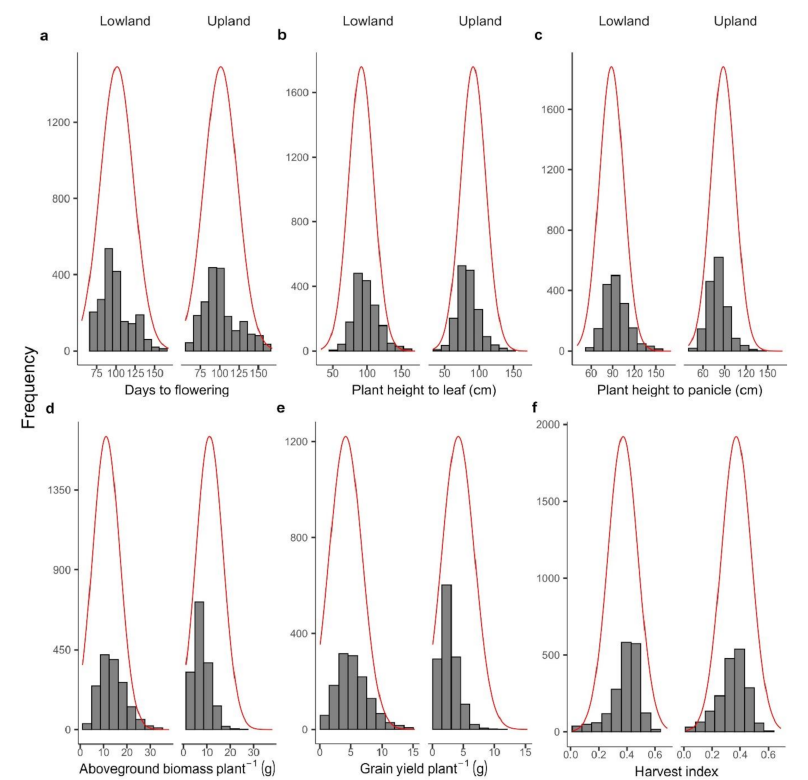
Figure 2. Frequency distribution of the six traits in lowland and upland conditions. Note: ( a ) Days to flowering. ( b ) Plant height to leaf (cm). ( c ) Plant height to panicle (cm). ( d ) Aboveground biomass plant − 1 (g). ( e ) Grain yield plant − 1 (g). ( f ) Harvest